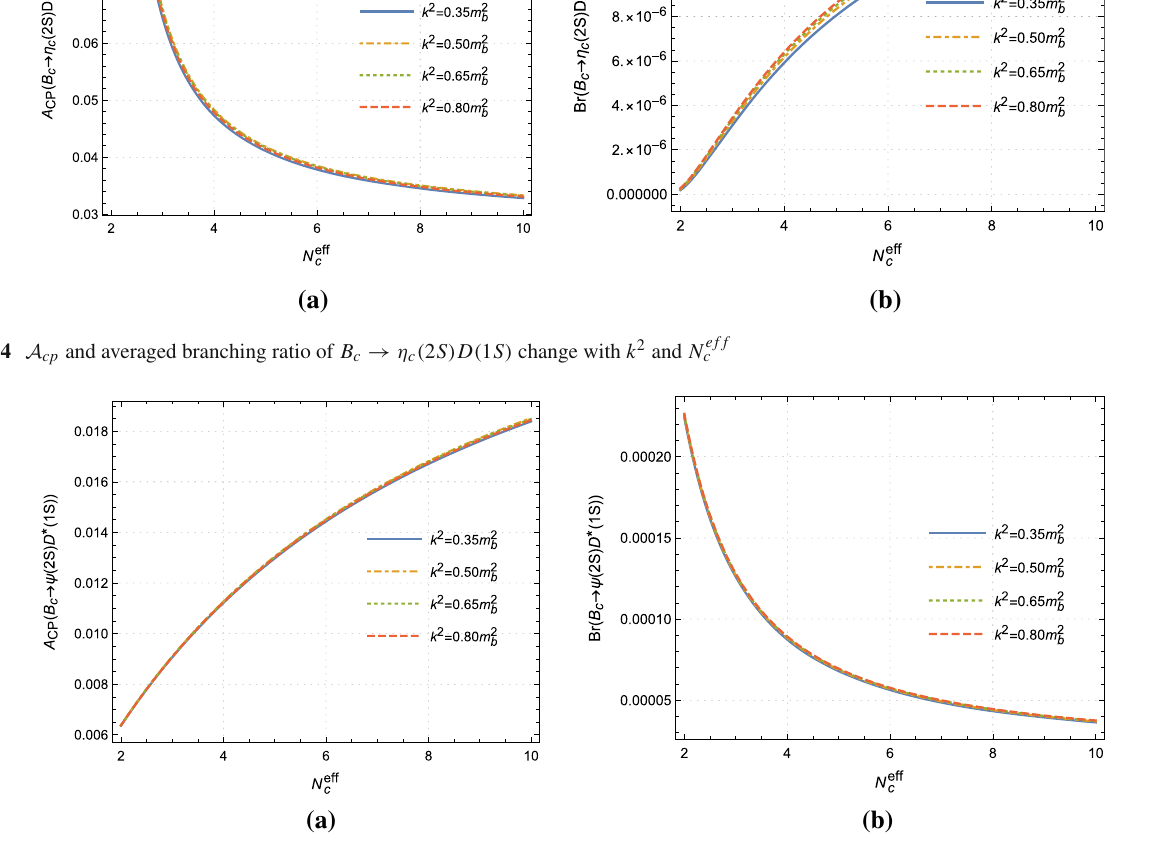
Fig. 5 A cp and averaged branching ratio of B c → ψ( 2 S ) D ∗ ( 1 S ) change with k 2 and N ef f